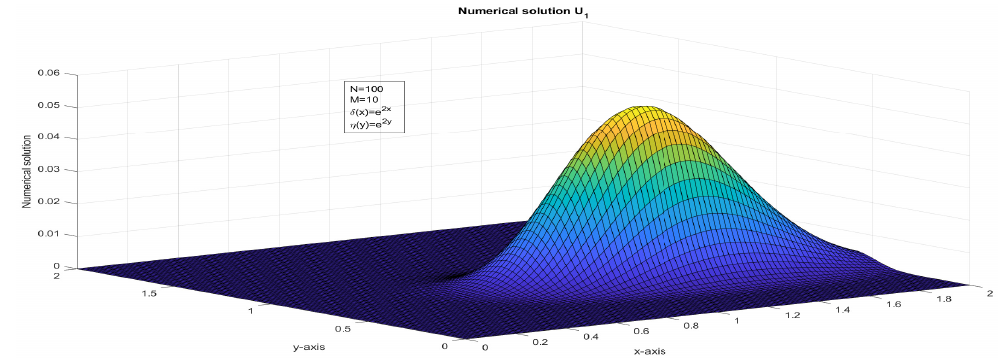
Figure 9. The surface plot illustrates the numerical solution, U 1 , of Example